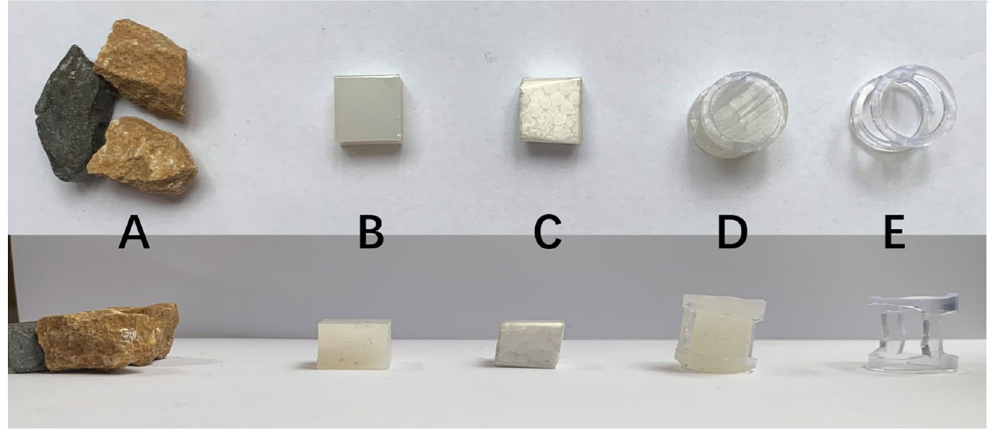
Figure 2. ( A ) Natural stones used in the initial training (8.21 ± 1.05 g). ( B ) Rubber blocks with a higher density than water (3.06 ± 0.03 g). ( C ) Foam blocks with a lower density than water (0.08 ± 0.01 g). ( D ) Solid cylinders (3.77 ± 0.05 g). ( E ) Hollow cylinders (1.04 ± 0.01